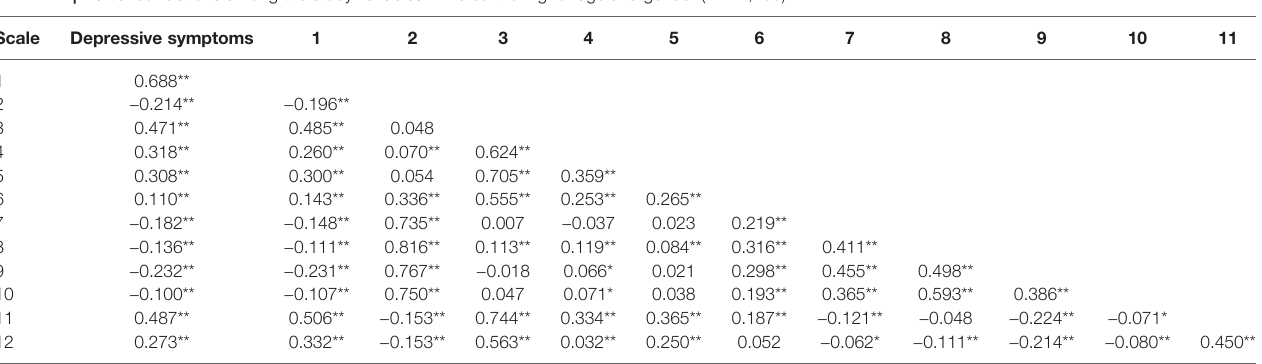
TABLE 1 | Partial correlations among the study variables while controlling for age and gender ( N = 1,265).